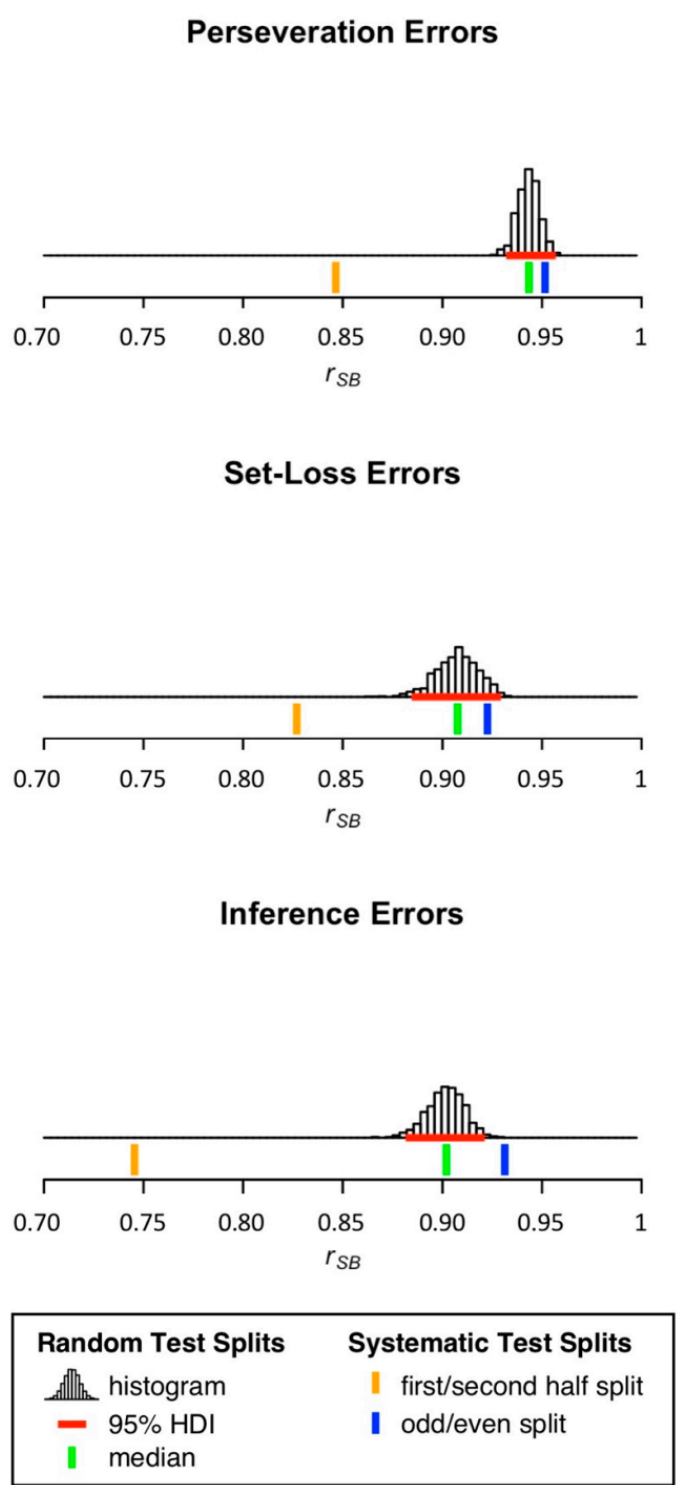
Figure 2. Distribution of split-half reliability estimates for the number of PE, SLE, and IE. 95% HDI = 95% highest density